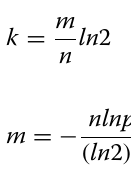
Pailliar algorithm is a basic probabilistic encryption algorithm and Pailliar encryption algorithm has additive